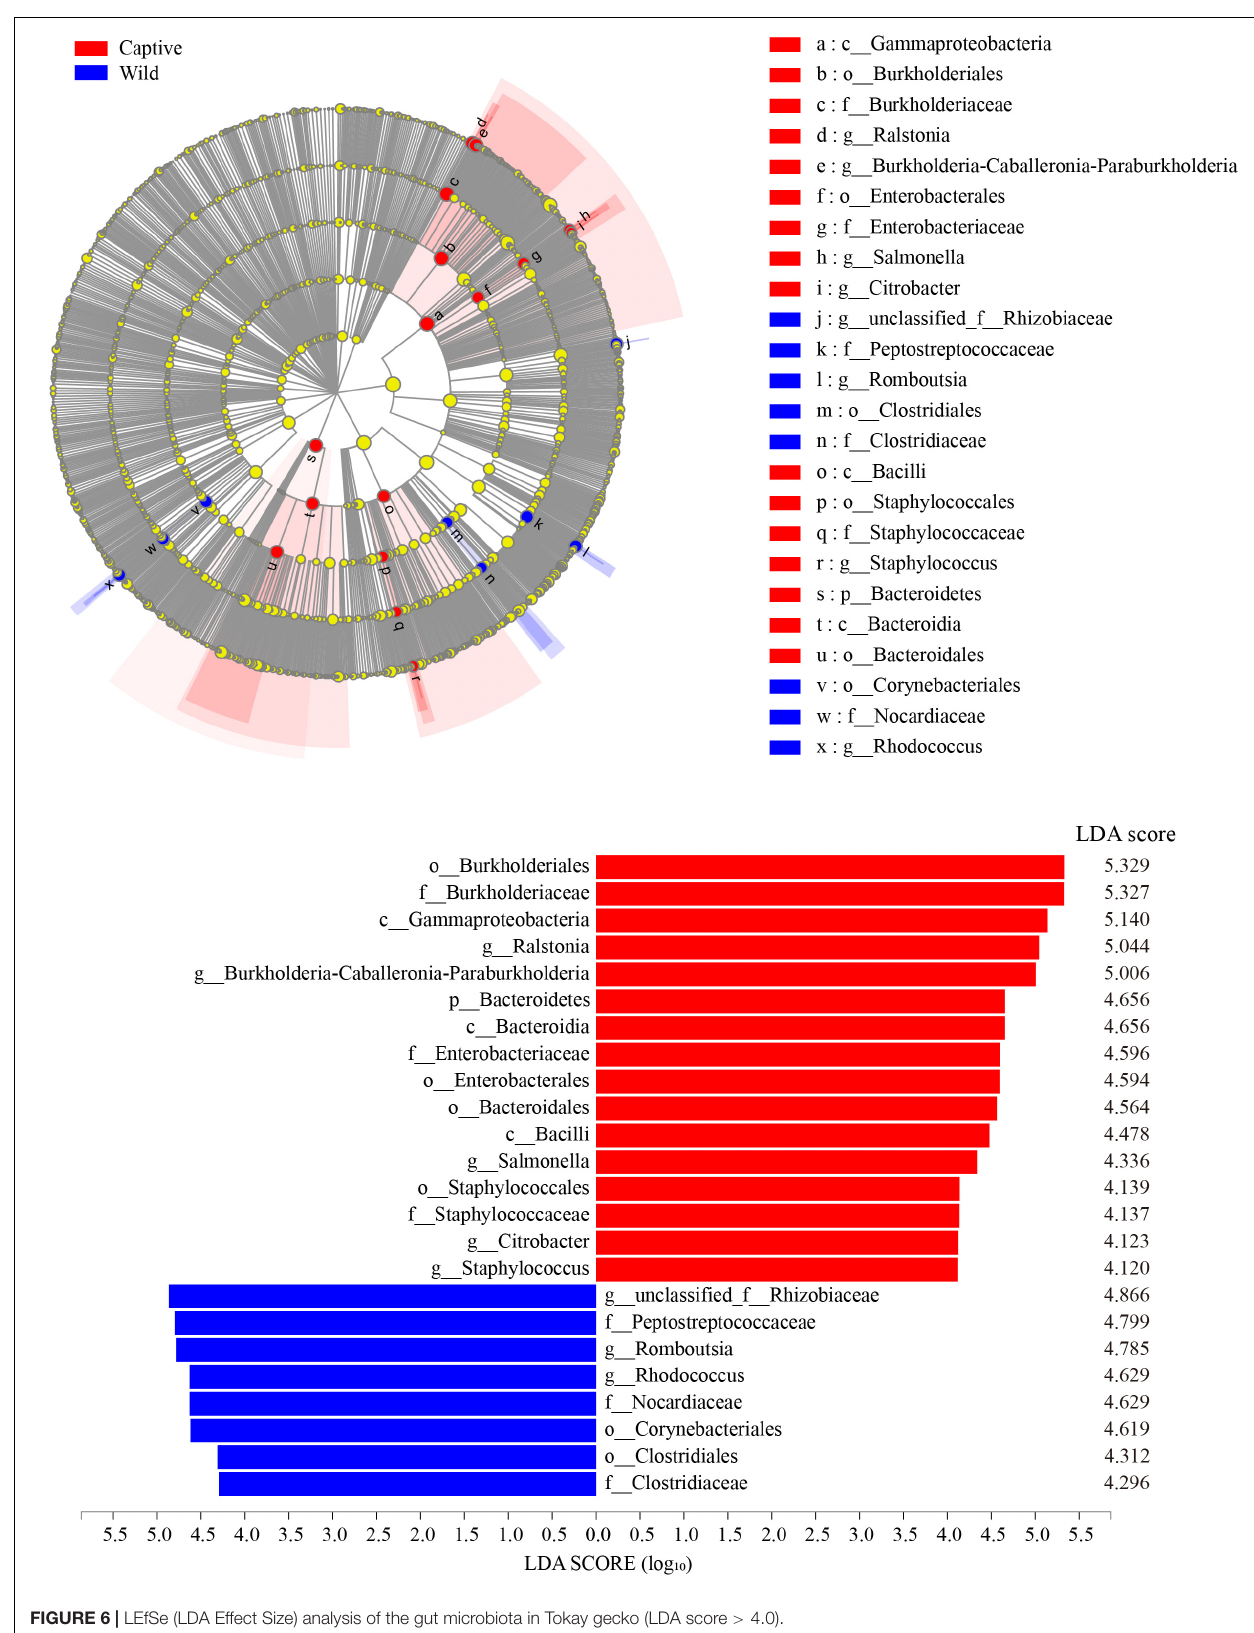
Frontiers in Microbiology |